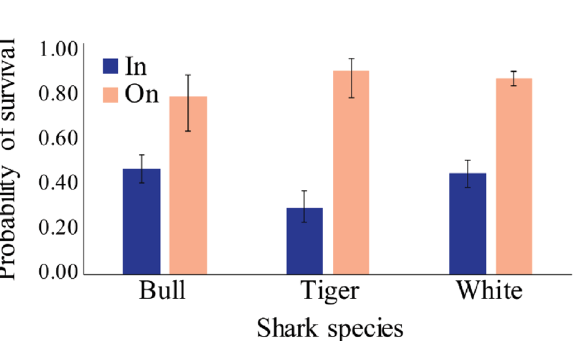
Figure 5. Percentage of injury locations (on human body) ( a ) across shark species, ( b ) across water activity type. Colours in pie charts match body part colours. Other (green) includes data with no injury recorded.